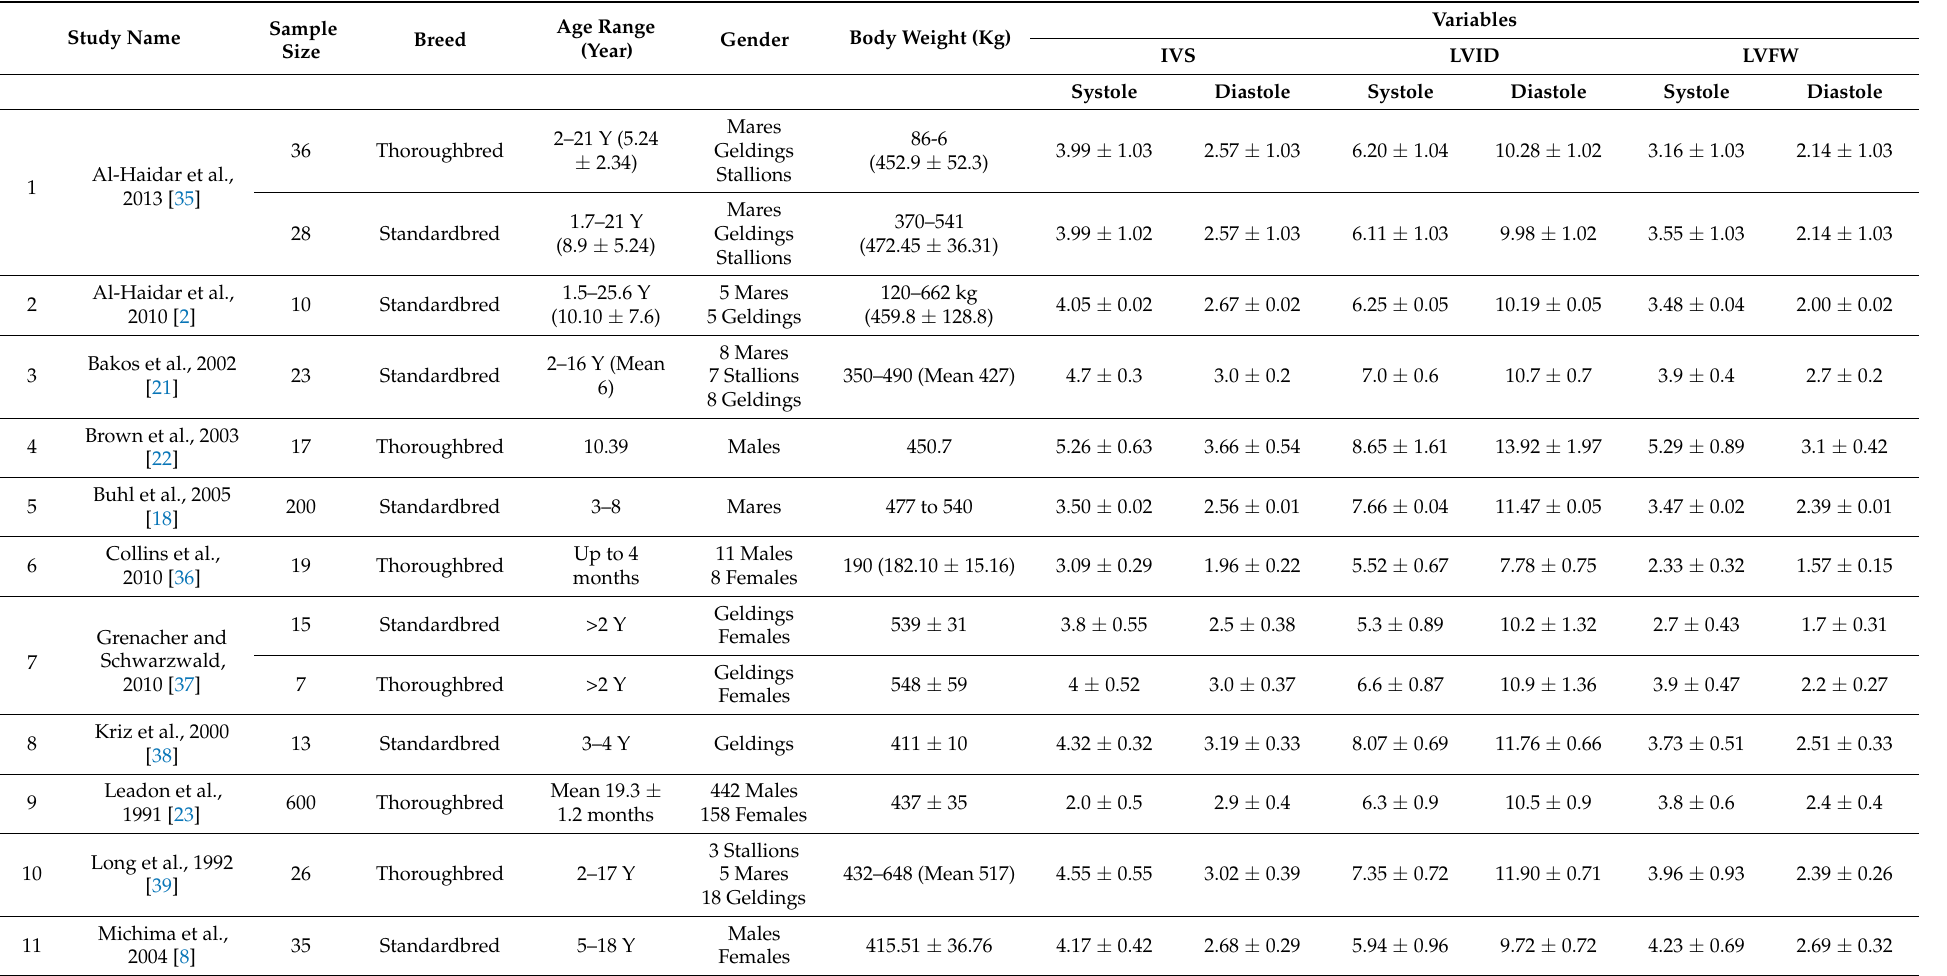
Table 1. Descriptive statistics for M-mode echocardiographic measurements of cardiac diameters in Thoroughbred and Standardbred